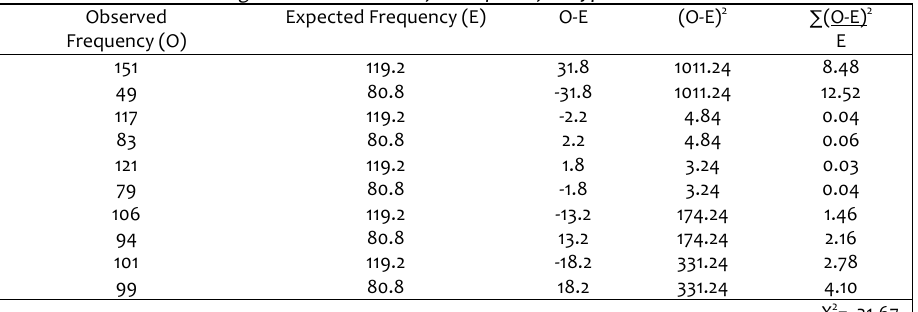
Figure 6: Calculation of chi ‐ square for hypothesis 1